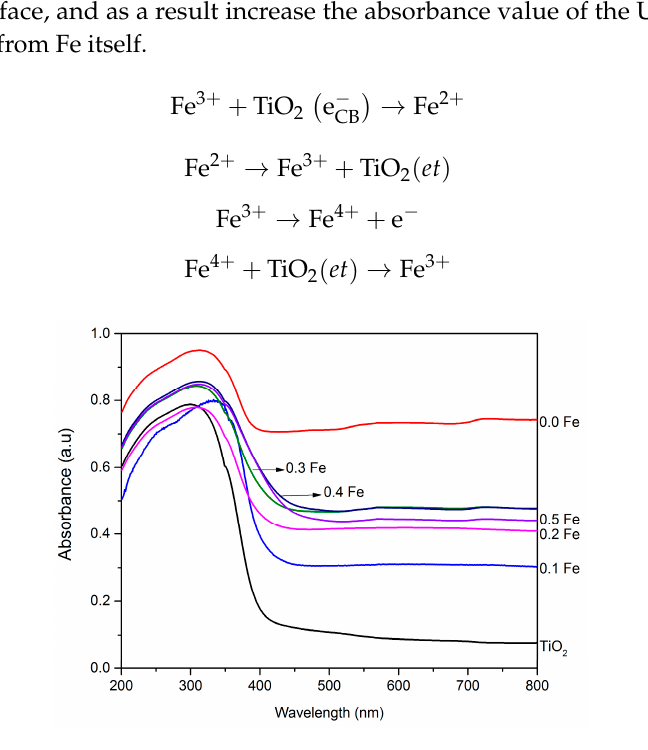
Figure 2. Diffuse reflectance spectra of the photocatalyst. Table 1. Band-gap energy (E g ) of the photocatalyst.